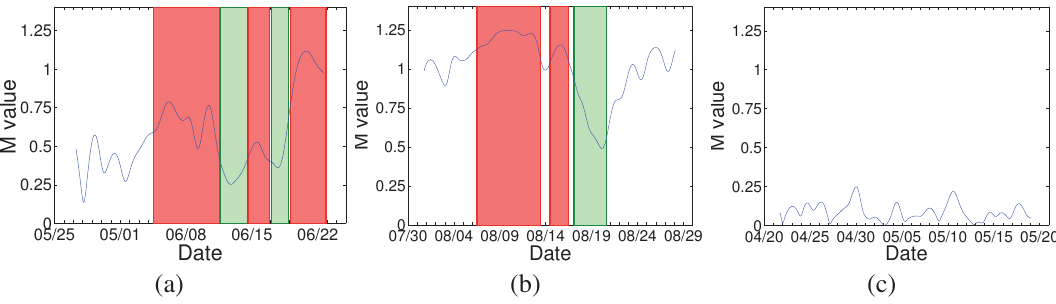
Fig. 6. M values for (a) the trajectory of the oceanic buoy 255 plotted in Fig. 3a, (b) the trajectory of the ice-tethered buoy 1897 plotted in Fig. 4a and (c) the trajectory of the buoy 12825 plotted in Fig. 5a. The red and green rectangles respectively correspond to those shown in Figs. 3 and 4.